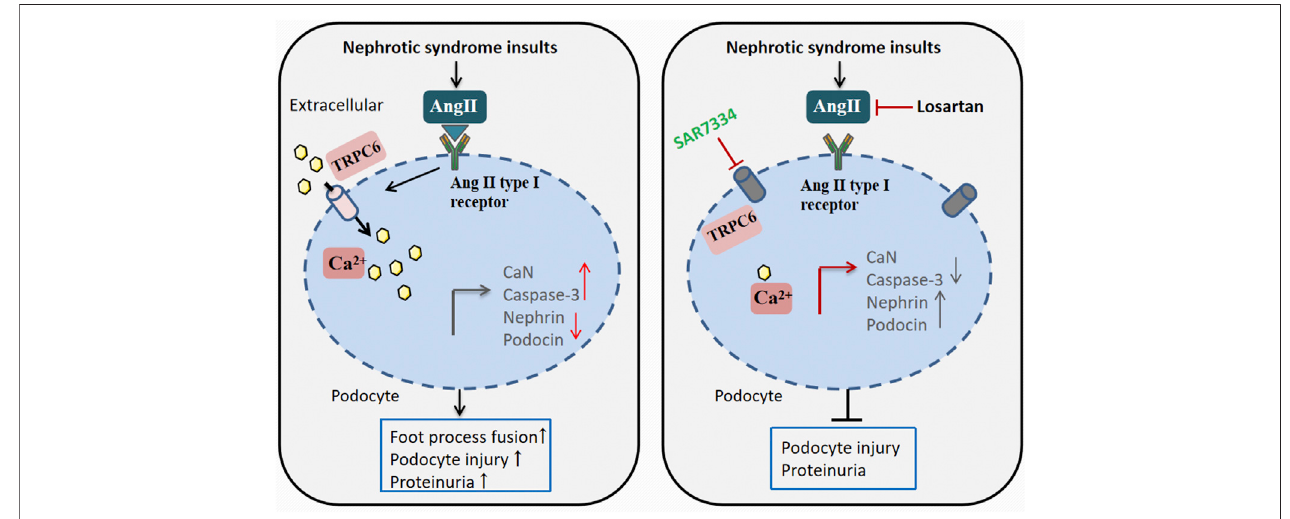
FIGURE 8 | A working model for losartan and transient receptor potential cation channel 6 (TRPC6) antagonist SAR mitigating the NS-elicited podocyte injury via targetingtheAng Ⅱ -controlled TRPC6 cellularcalciumin fl uxdefensepathway. TheTRPC6-dictatedregulationofCa 2+ playsakeyroleingoverningtheinjuryresponseat a delayed/late phase. Ang Ⅱ can catalyze TRPC6 activation. NS insults are capable of eliciting Ang Ⅱ hyperactivity. This enhances Ang Ⅱ -mediated TRPC6 activation, leadingtoCaNandapoptosissignalexpressionandactincytoskeletonmoleculardegradationthatresultsinpodocyteinjury,aggravatingproteinuria.Losartancan directly inhibit Ang Ⅱ activity, as well as SAR, inhibit TRPC6 activity, and thereby suppress TRPC6-mediated calcium in fl ux at the same effect, mitigate the expression export of CaN and apoptosis signal, increase actin cytoskeleton molecular accumulation, and ultimately attenuate podocyte injury and proteinuria. CaN, calcineurin.